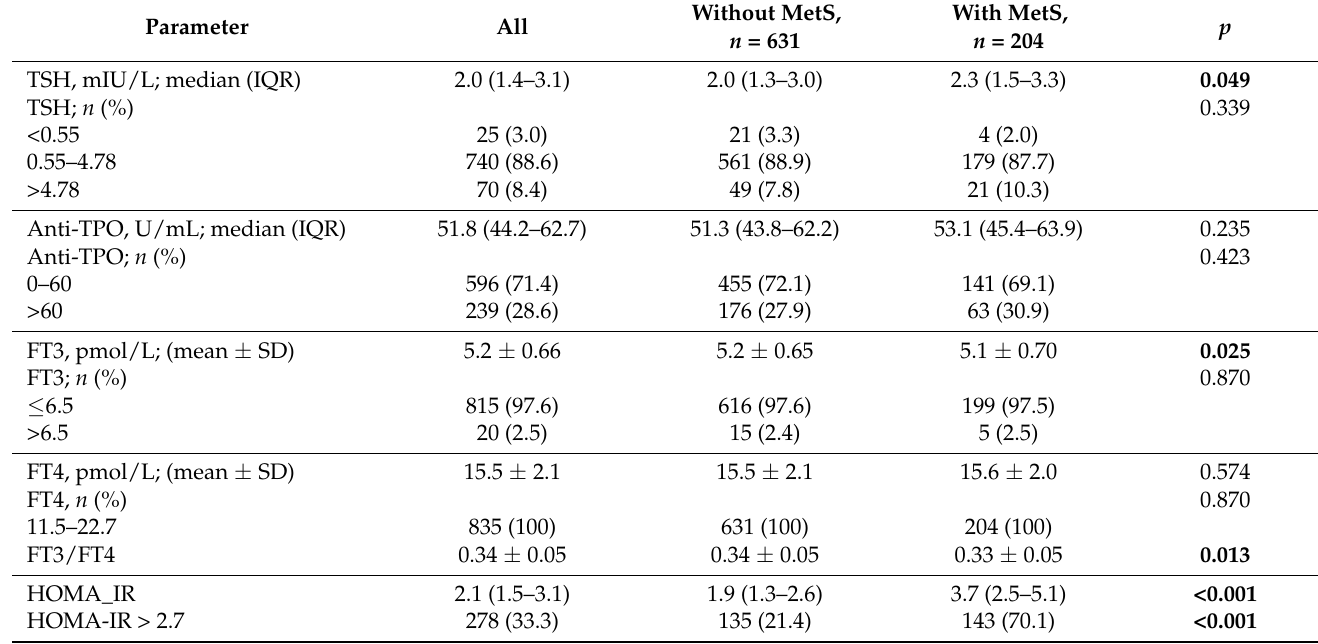
Table 5. The biochemical and homeostasis model assessment of IR (HOMA-IR) parameters of subject groups without and with metabolic syndrome.